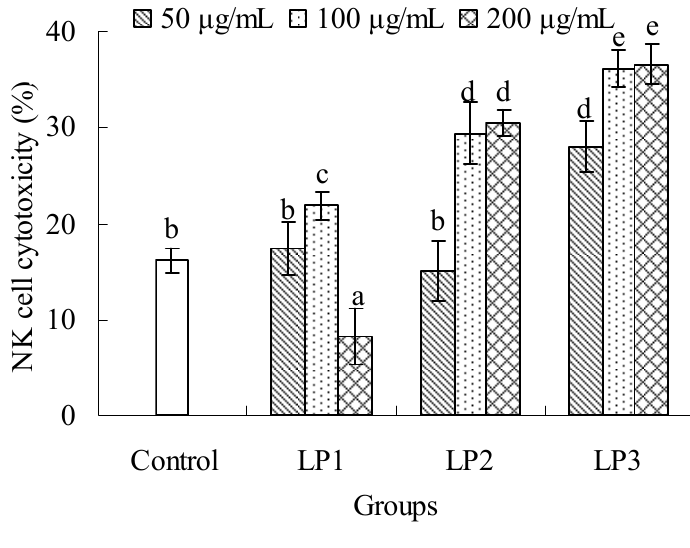
Figure 6. Effects of LP1-3 on the cytotoxicity of NK cells. NK cell cytotoxicity was assessed by MTT assay and expressed as means ± SD (n = 3). The statistically significant differences among the groups were evaluated with ANOVA followed by the S-N-K